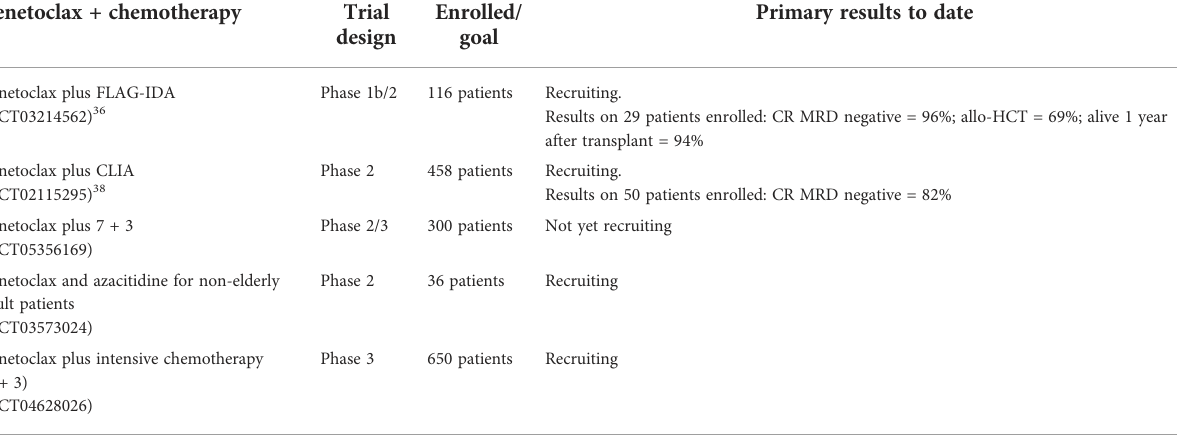
TABLE 4 Bcl2 inhibitors/Venetoclax + intensive chemotherapy in AML young and fi t patients. Venetoclax +